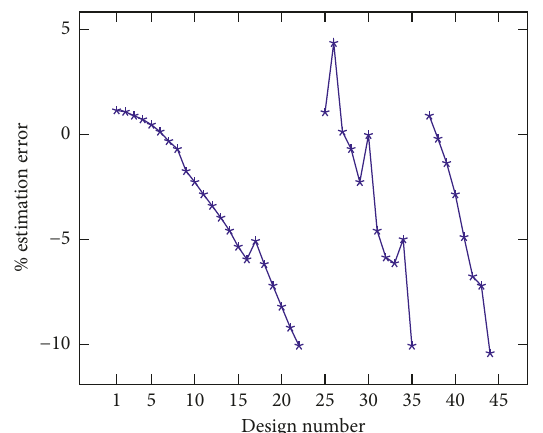
Figure 12: Estimated and measured power for different designs.